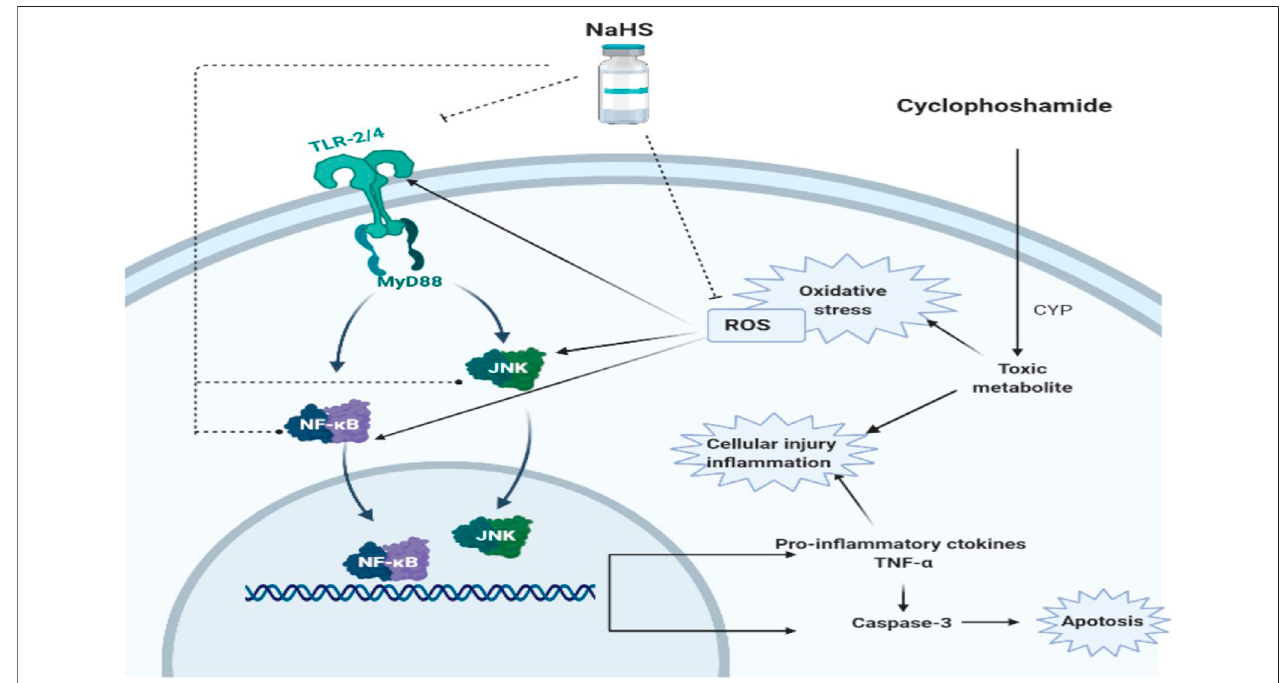
Frontiers in Pharmacology |